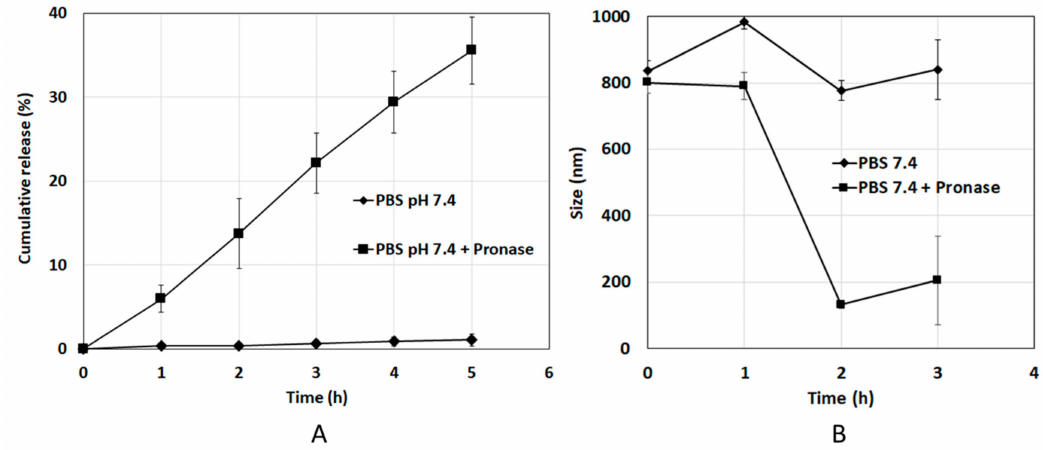
Figure 4. ( A ) Cumulative release profiles of DOX from DOX-HSA-MPs and ( B ) size change of DOX-HSA-MPs with time in the absence and presence of Pronase ® in PBS pH 7.4 at 37 ◦ C. The values are displayed as mean and SD ( N =